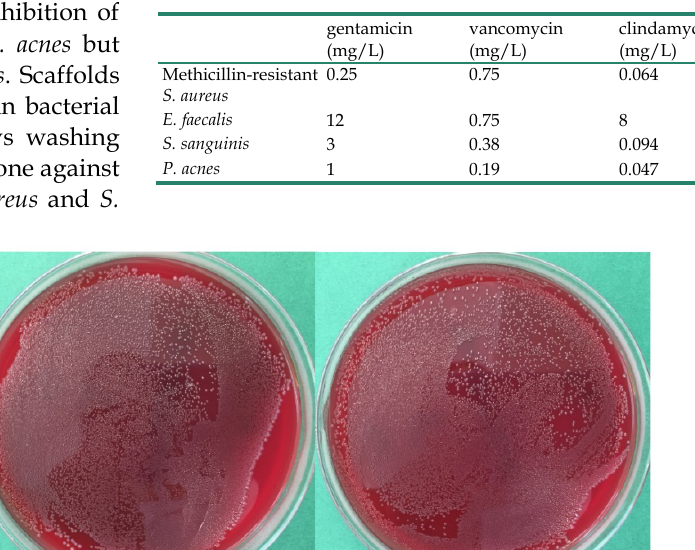
Table 1 : Minimal inhibitory concentration as determined by E-test